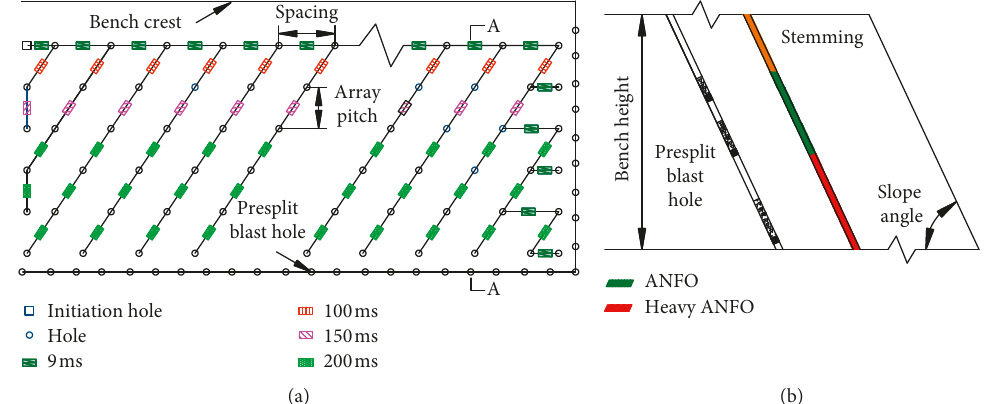
Figure 5: Sketch map showing cast-blasting parameters. (a) Hole pattern parameters and (b) indicative loading design.